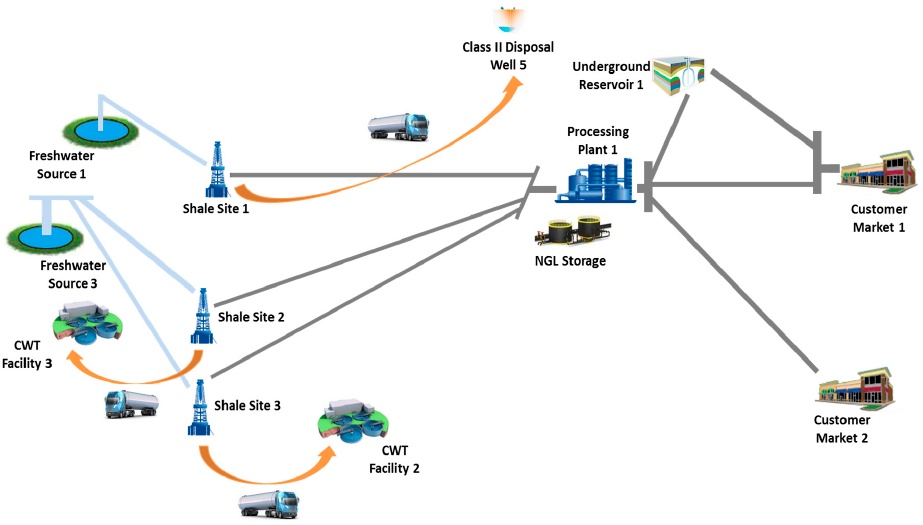
Figure 5. Optimal shale gas supply chain network under market uncertainty.